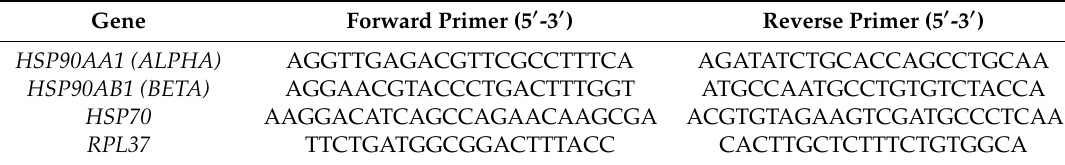
Table 3. Primer sequences used in the